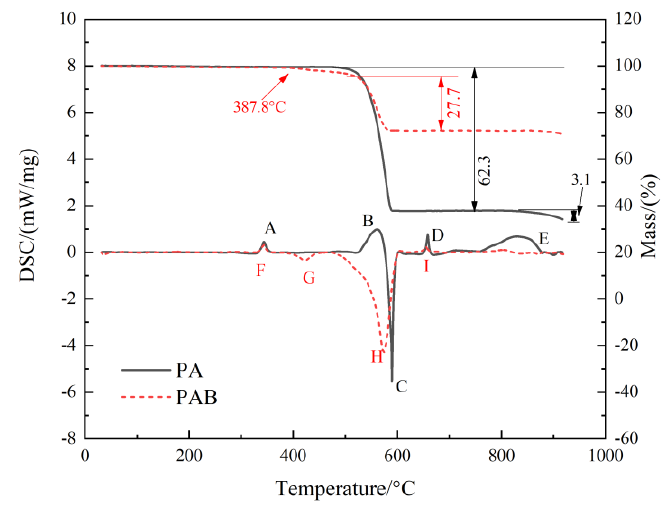
Figure 13. TG-DSC curve of PA and PAB. Table 4. Heat absorption and release of peaks in DSC curve.